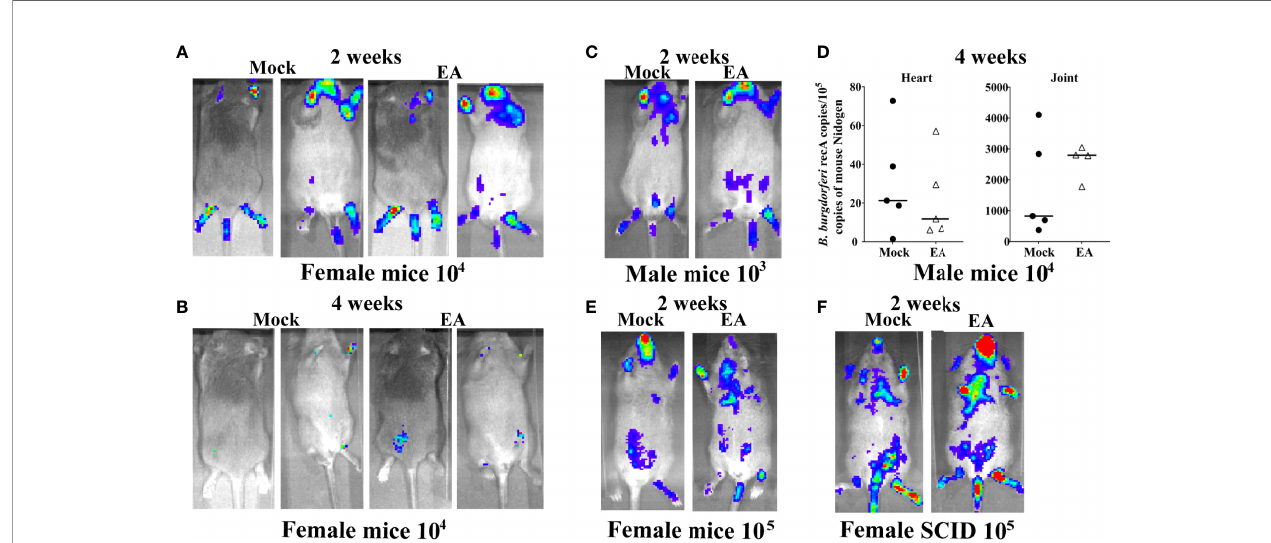
FIGURE 1 | Colonization of organs of 4-week-old C3H/HeJ mice by Borrelia burgdorferi N40 strain did not change after EA treatment. (A, B) Real-time images of a representative female C3H/HeJ infected mouse (10 mice for each treatment) using IVIS-200 displayed bioluminescence as a semi-quantitative indicator of B. burgdorferi colonization in different organs of mice at 2 (A) and 4 weeks (B) post-infection. Spirochete burden was comparable in mock- and EA-treated mice. (C) Overall, light emission in representative male C3H/HeJ mouse, representing colonization of organs and spirochetal burden at 2 weeks post-infection, was not different from that observed in female mice (A) and was comparable in mock- and EA-treated mice. (D) Determination of burden of B. burgdorferi by real-time qPCR con fi rmed results obtained by live imaging (C) , such that mock- and EA-treated mice showed similar levels of heart and joint colonization of 5 mice each. Bars indicate median values. (E) Increasing infection dose to 10 5 B. burgdorferi /mouse did not appreciably increase over colonization levels of organs in mice infected by 10 4 spirochetes/mouse. (F) SCID mice showed higher colonization of organs by B. burgdorferi (higher bioluminescence radiance) than immunocompetent mice (A – E) ; however, spirochete burden was comparable in mock- versus EA-treated mice. EA, electroacupuncture; SCID, severe combined immunode fi